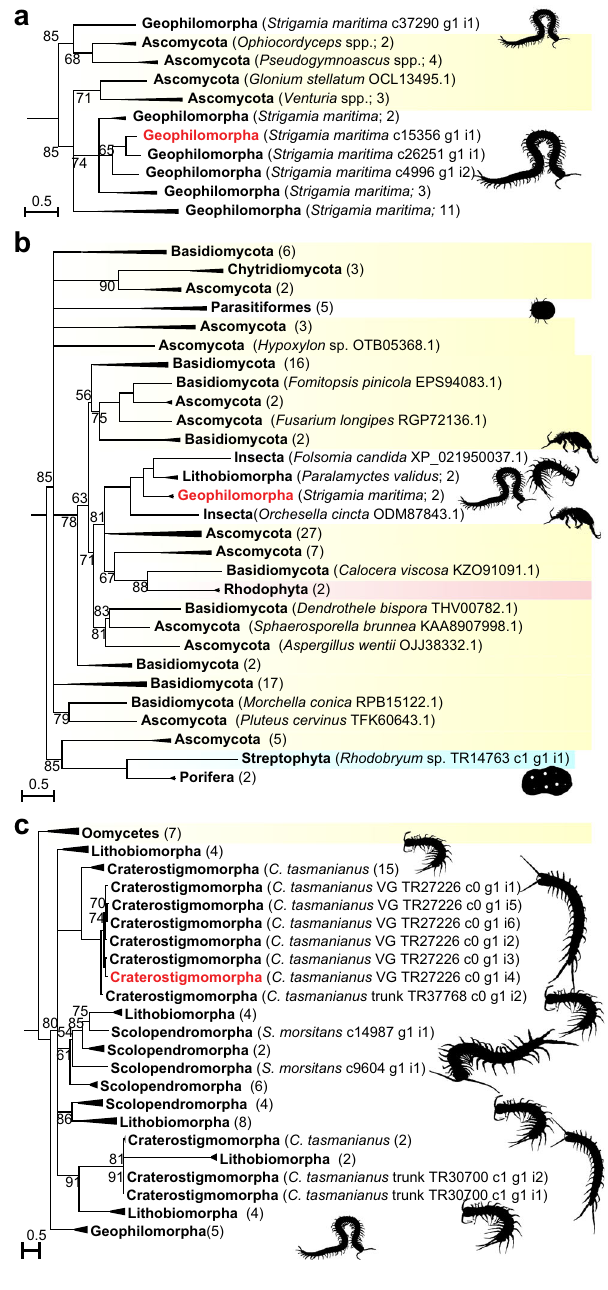
Fig. 5 Maximum likelihood trees showing eukaryotic HGTs between fungi, oomycetes, and centipedes. a Tree of GEOTX02 homologues showing that the centipede sequences are distributed across two clades, and interleaved with ascomycete sequences. The direction and number of HGTs (one or two) is uncertain. The tree was reconstructed using the VT + I + G4 model and is midpoint rooted. For the uncollapsed tree see Supplementary Fig. 5. b Tree of unchar05 homologues showing the four centipede sequences grouping in a clade with two collembolan sequences, nested within a paraphyletic backbone of fungal sequences. The tree shows that the centipede sequences likely originated from two fungal HGTs, one into the geophilomorph lineage, and one within the lithobiomorph lineage. The tree was reconstructed using the WAG + R5 model and is midpoint rooted. For the uncollapsed tree see Supplementary Fig. 6. c Tree of unchar16 homologues showing a clade of centipede sequences that is the sister group to a clade of oomycete sequences. The direction of HGT is unclear. The tree was reconstructed using the VT + R3 model and is rooted with the oomycete sequences. For the uncollapsed tree see Supplementary Fig. 7. For each tree, bootstrap support values are shown for each clade and clades with support <50% are collapsed into polytomies. Clades without bootstrap values have >95% support. Centipede sequences are coloured black (present in transcriptomes) and red (present in transcriptomes and venom proteomes). Highlighted sequences are Fungi (yellow), Rhodophyta (reddish brown), and Streptophyta (cyan). Metazoan sequences are not highlighted. Collapsed clades have the number of included sequences indicated in parentheses. Non-centipede images are sourced from Phylopic (www.phylopic.org; credit for the Collembola images is with Birgit Lang: